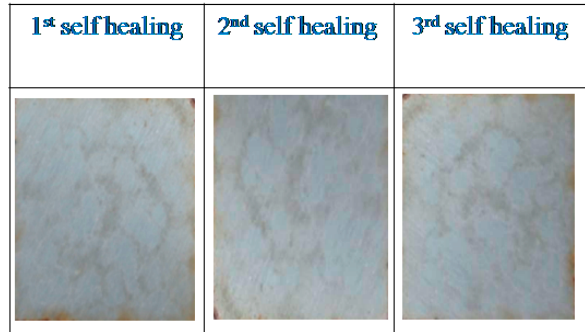
Figure 4. Typical photographs of exposed PU-11-3-3-CeO 2 -P-Healed coating.